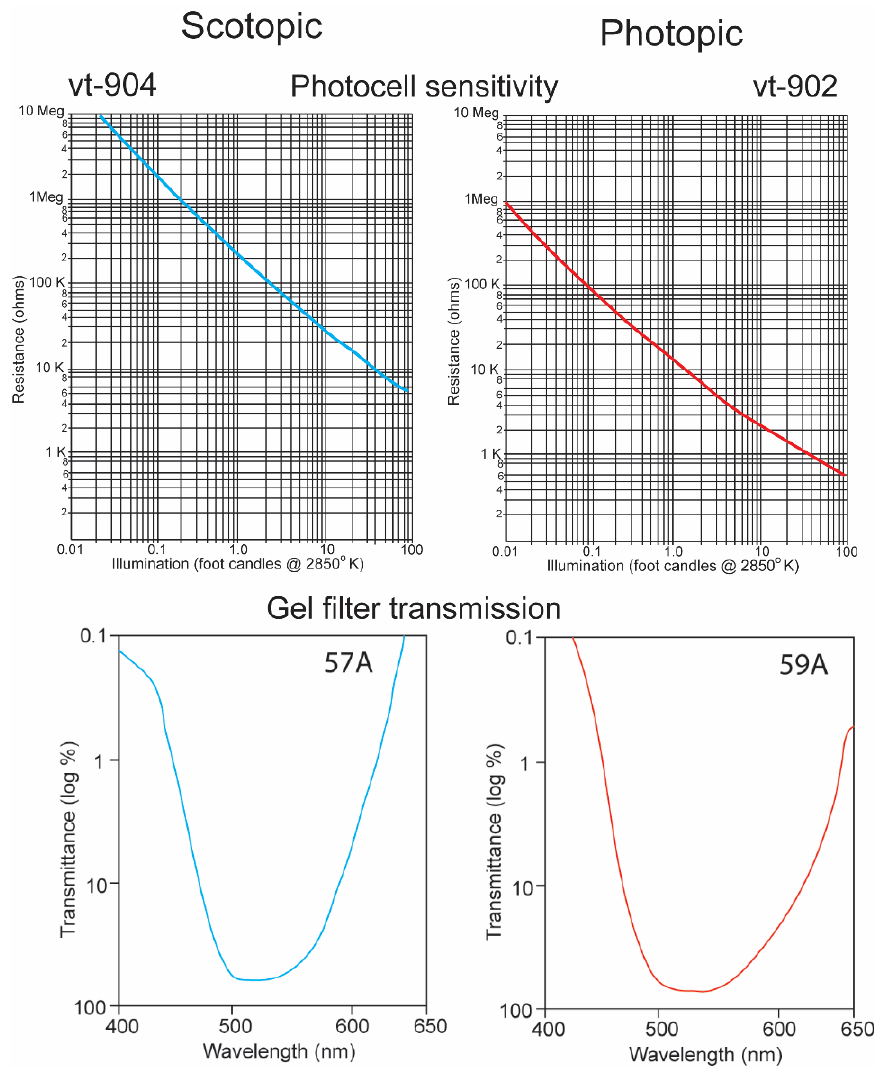
Figure 6. Resistance plotted as function of irradiance for vt-904 and vt-902 photocells (above) [16]. Transmission as function of wavelength for 57A and 59A Kodak gel filters [17].